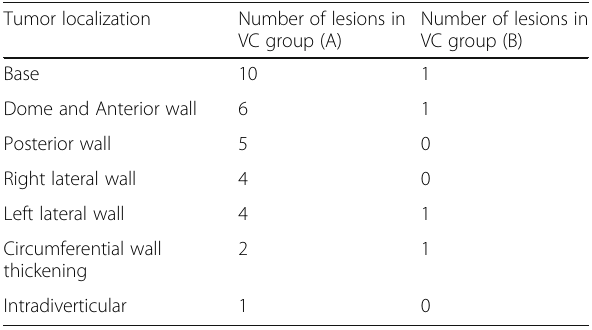
Table 2 The localization of the detected lesions in different bladder walls by virtual cystoscopy Tumor localization